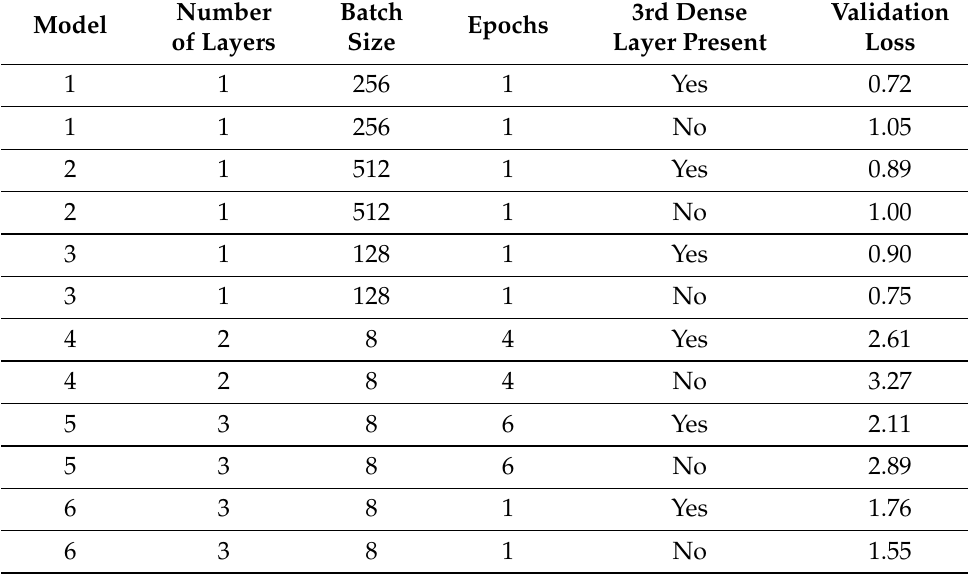
Table 18. Validation loss for the 6 best models after removing the third dense layer.